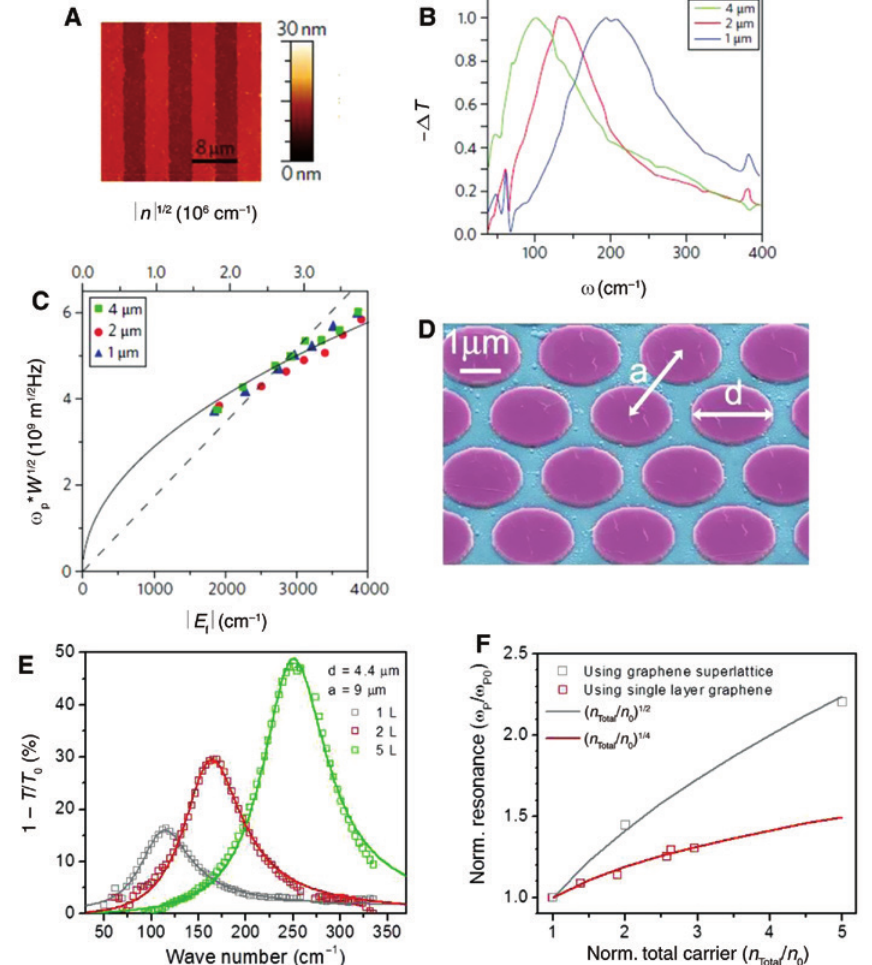
Figure 1: Terahertz plasmons of graphene microstructures. (A) AFM image of a graphene microribbon array with ribbon width W = 4 μ m. (B) Extinction spectra for microribbon arrays with ribbon width W = 4, 2, and 1 μ m, respectively. The intensities are normalized to have the same peak height. (C) Normalized plasmon frequency as a func- tion of Fermi energy and carrier density. The plasmon frequencies are normalized with the ribbon width. Therefore, the data points for 1, 2, 4 and μ m ribbons are collapsed to the same square root scaling relation (solid curve). The dashed line is the best fit using a linear depend- ence, which deviates from the data. (D) SEM image of a graphene microdisk array. (E) Extinction spectra for one-, two-, and five-layer disks. (F) Normalized resonance frequency as a function of the normalized carrier density for multilayer structures (gray squares) and a single-layer case (red squares). (A–C) Reprinted with permission from [14]. © Copyright 2011 Nature Publishing Group. (D–F) Reprinted with permission from [15]. © Copyright 2012 Nature Publishing